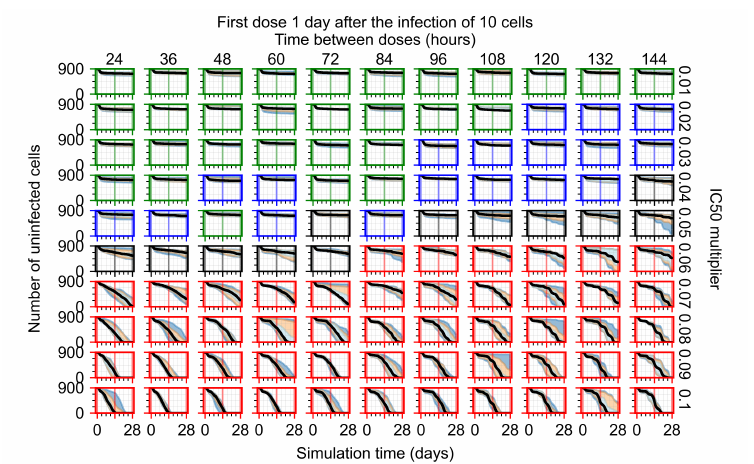
Figure A109. Uninfected